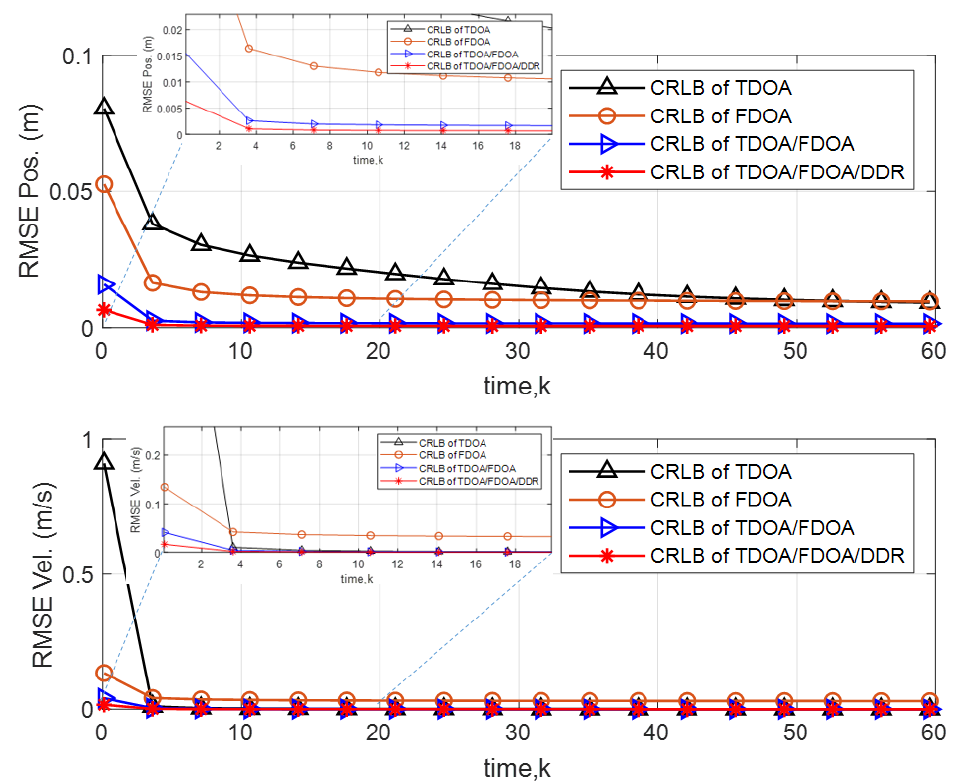
Figure 11. CRLB comparison between TDOA, FDOA, hybrid (TDOA/FDOA), and Tri-combination of (TDOA/FDOA/DDR). In this figure, the same scenario and input parameter has been implemented in Figure 9b. Additionally, TDOA/FDOA/DDR was computed and its performance compared. Authors’ own